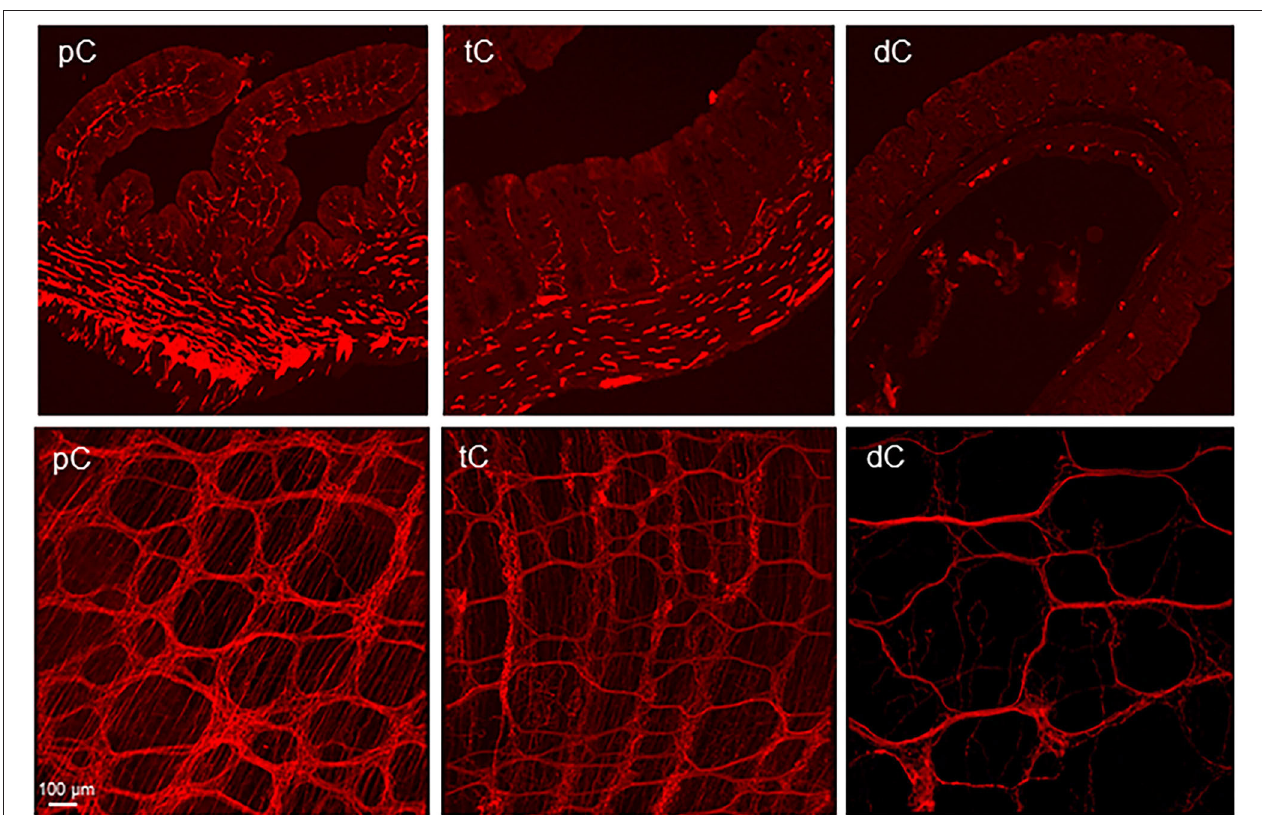
FIGURE 10 | Representative photomicrographs of the transduction by AAV-PHP.S-hSyn1-tdTomato farnesylated (PHP.S-tdTf) in the mouse colon. PHP.S-tdTf (1 x 10 12 GC/mouse) was retro-orbitally injected 3 weeks before. The AAV-labeled nerves were abundant in the proximal colon (pC). Upper panel : transverse sections showing all layers of the colon wall. The iv PHP.S-tdTf-transduced nerve terminal fibers are well-demonstrated in the mucosa, and the nerves in muscular layers are very dense. Lower panel : flattened colon wall. The longitudinal axis of all samples is placed along the left-right direction of the photomicrographs. Images show the myenteric plexus and the nerves innervating the circular muscles in the pC and transverse colon (tC). The longitudinal interganglionic strands were labeled in all the segments. Scale: 100 µ m same for all